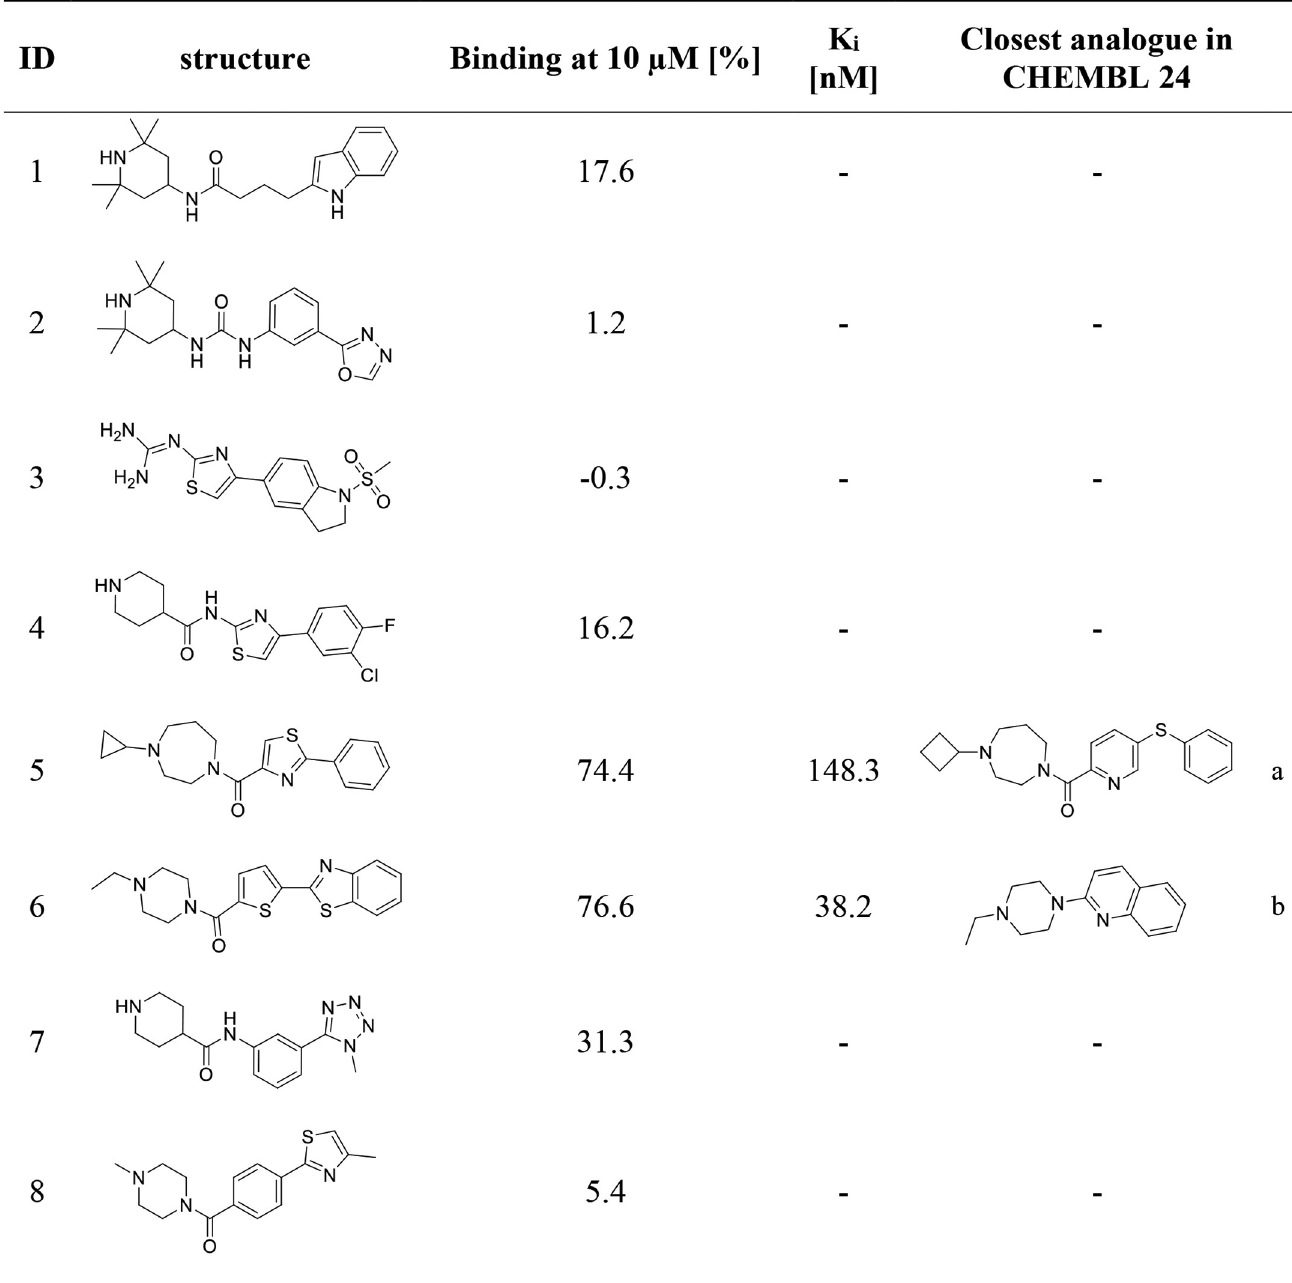
Fig 4. In-vitro validation of virtual screening hits identified 2 novel nanomolar H 3 R ligands. Activity results of radioligand depletion assay against H 3 R. K i data is presented as mean values calculated from at least three independent experiments, each performed in triplicates. a CHEMBL1172076 with Tanimoto score of 0.53 when comparing with compound 5 using Morgan fingerprints, b CHEMBL180478 with Tanimoto score of 0.36 when comparing with compound 6 using Morgan